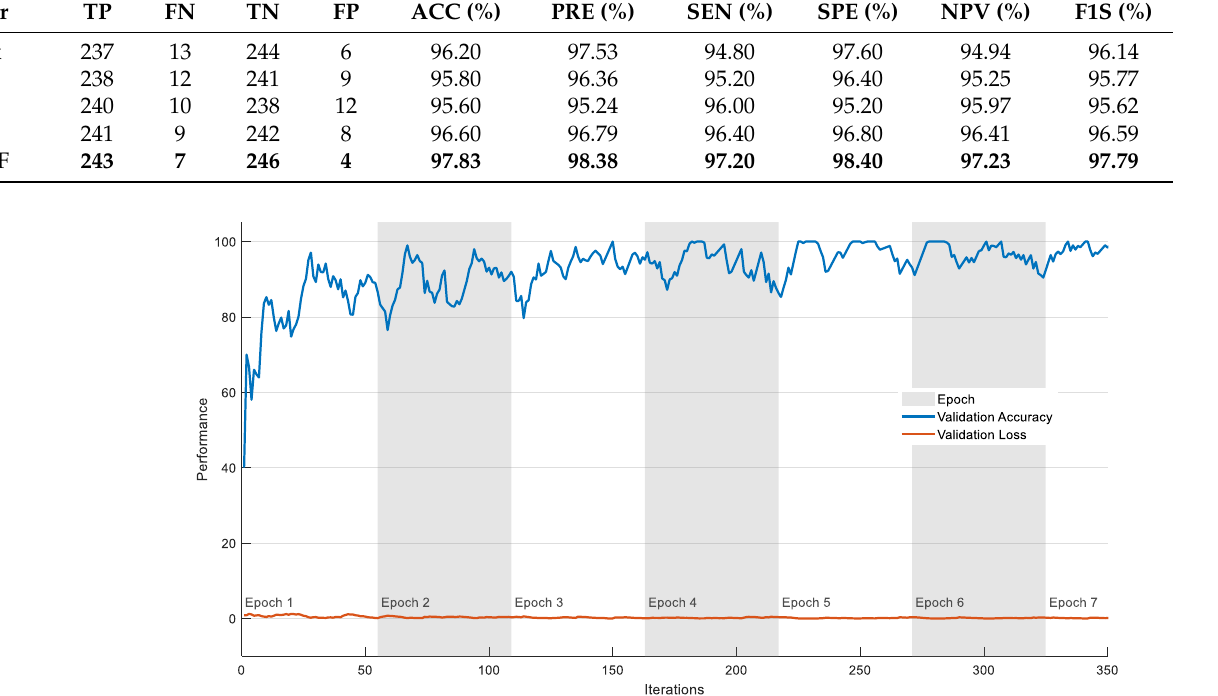
Table 5. Disease detection performance of VGG19 with DF + HCF with different classifiers. Best values are shown in bold.